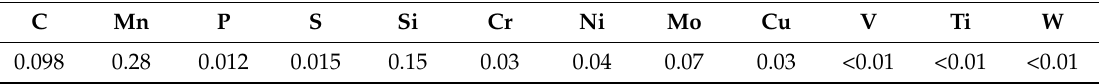
Table 1. Chemical composition of tested steels.